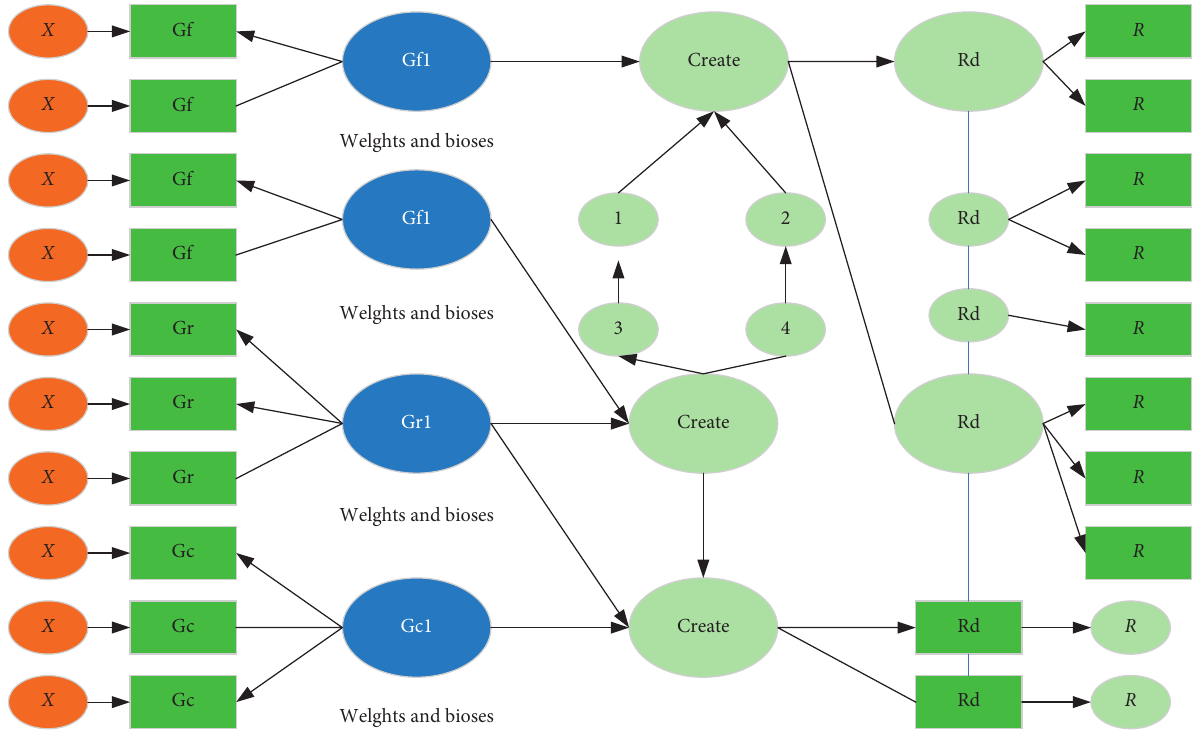
Figure 1: Topological model of cloud fuzzy neural network